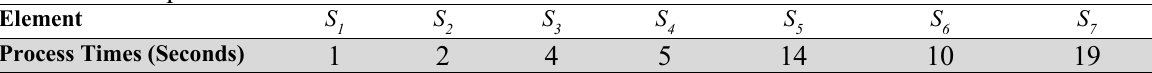
Production line